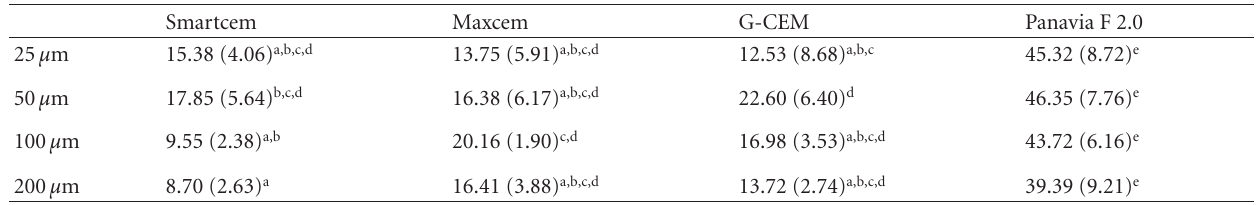
Table 3: Microtensile bond strength